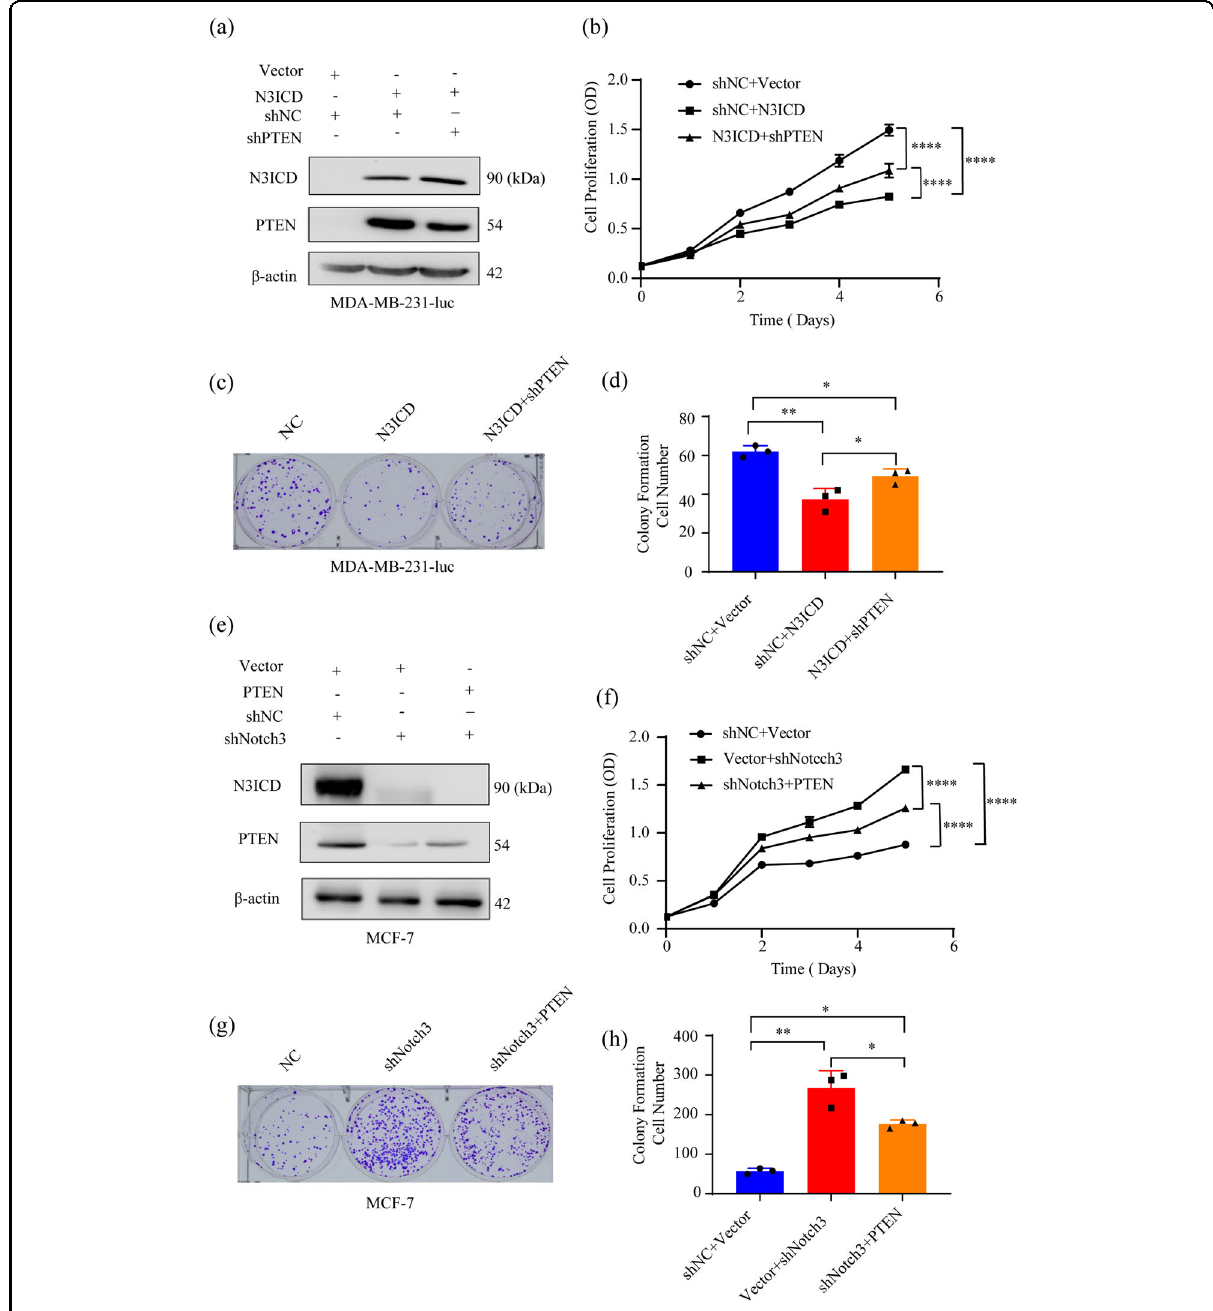
Fig. 3 Ectopic Notch3 expression inhibits proliferation and tumorigenesis in vitro, which is attenuated by PTEN silencing. a Notch3 and PTEN expression in MDA-MB-231-luc cells measured by western blotting following stable N3ICD overexpression, with or without PTEN knockdown. β -actin served as an internal control. b Stable N3ICD expression inhibited MDA-MB-231-luc cell growth in vitro. This effect was attenuated by PTEN silencing with shRNA. c N3ICD overexpression inhibited colony formation, which was reversed by stable PTEN knockdown with shRNA. Representative pictures and quantitative data from the colony formation assays are presented. d Representative micrographs and data for Matrigel- coated assays. The stably transfected N3ICD MDA-MB-231-luc were co-transfected with shPTEN or shNC as a negative control. e Notch3 and PTEN expression in MCF-7 cells measured by western blotting following stable Notch3 knockdown, with or without stable PTEN overexpression. f Stable Notch3 knockdown induced MCF-7 cell growth in vitro, which was attenuated by PTEN overexpression. g Stable Notch3 knockdown promoted the colony formation, which was reversed by stable PTEN overexpression. Representative pictures and quantitative data from the colony formation assays are presented. h Representative micrographs for Matrigel-coated. Stably transfected shNotch3 MCF-7 cells were co-transfected with PTEN plasmid or negative control vector. Three independent experiments were performed, and all the data were analyzed using the two-sided t -test. * P < 0.05, ** P < 0.01, *** P < 0.001, **** P <